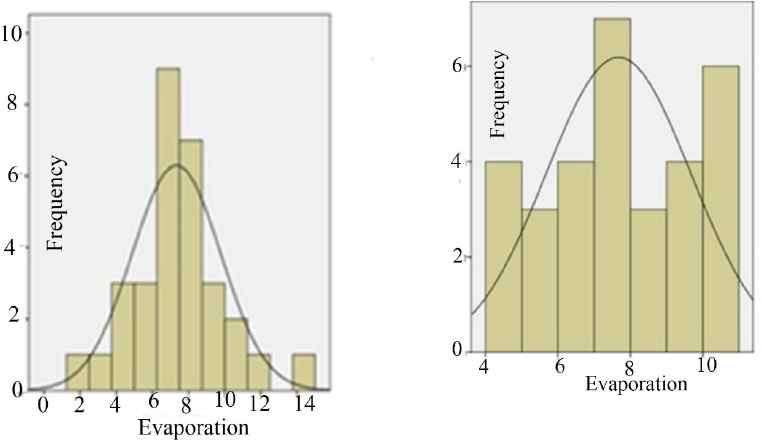
Figure 11. Temperature frequency in August 2008 ( Left ) and 2009 ( Right ).